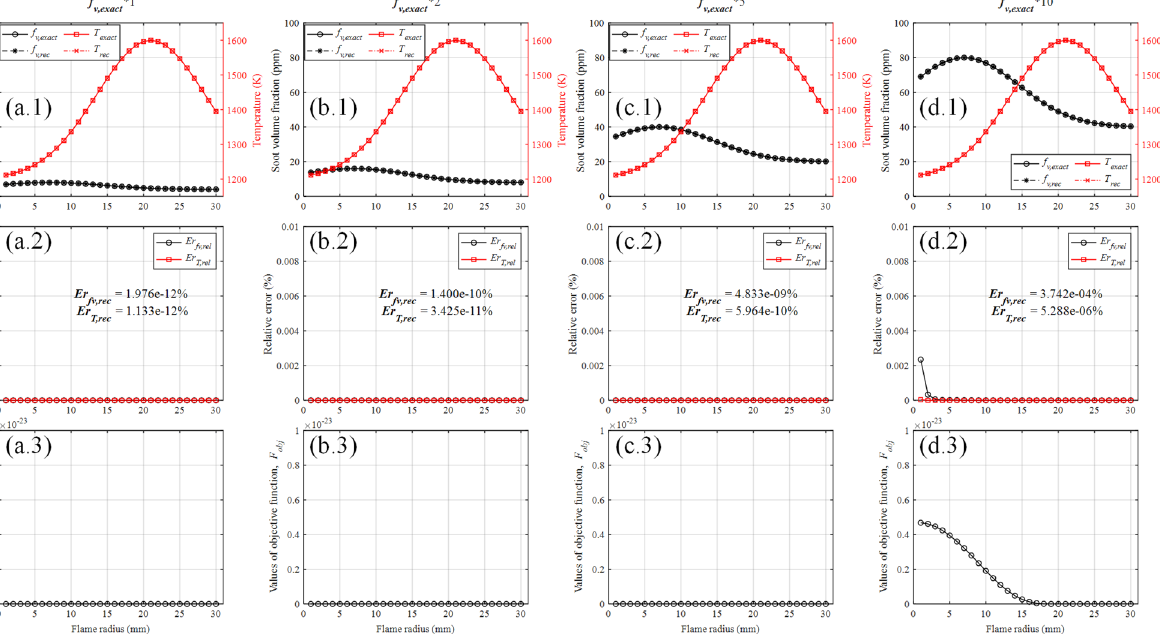
Figure 8. The reconstructed results with optically thick condition. ( a – d ) The input soot concentration field was increased to 1, 2, 5 and 10 times of the original,